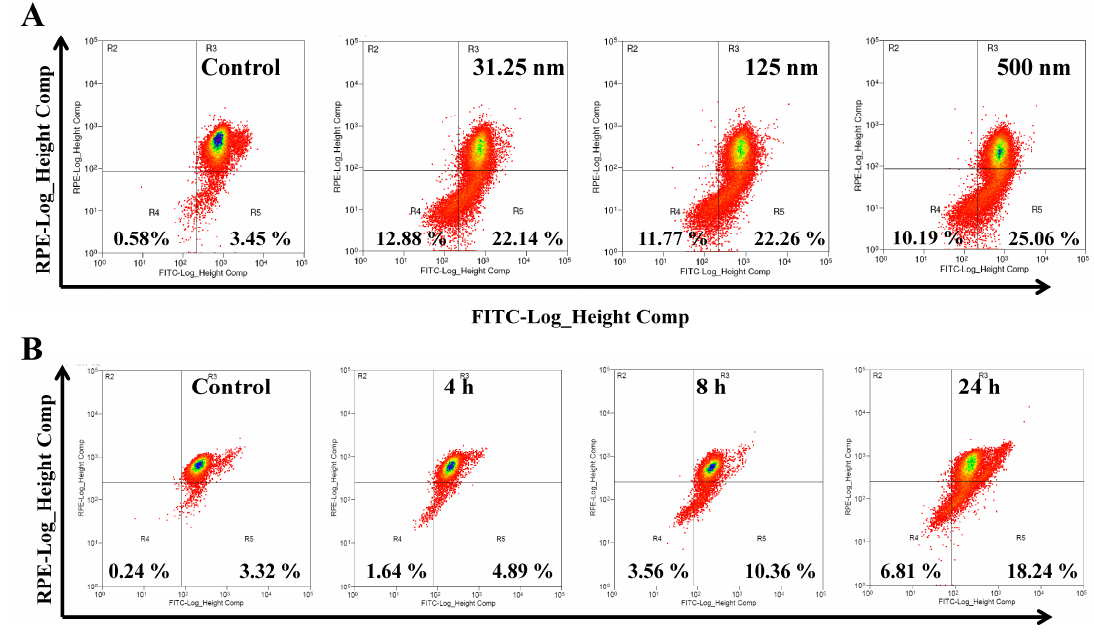
Figure 4. AAI induces the loss of MMP in K562 cells. ( A ) Treatment with AAI (0–500 nM) for 18 h disrupts the MMP in K562 cells. The scatter plot of the flow cytometry analysis shows the distribution of JC-1 aggregates and JC-1 monomers; and ( B ) AAI at 250 nM time-dependently induces the loss of MMP in K562 cells.